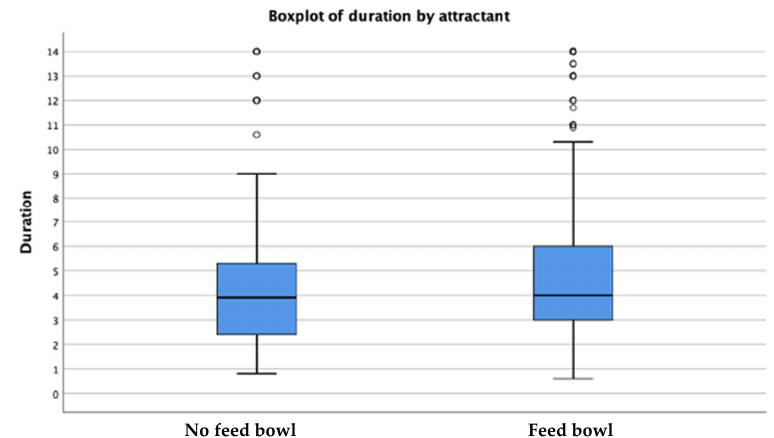
Figure 2. Time duration (in seconds) that animals need to respond to sound cues when an attractant is present/absent. The vertical lines indicate the range (minimum and maximum time in seconds), upper and lower quartiles with median (blue boxes), and outliers (represented by dots). Table 5. Estimates of duration (in seconds) in the presence/absence of attractant. Attractant